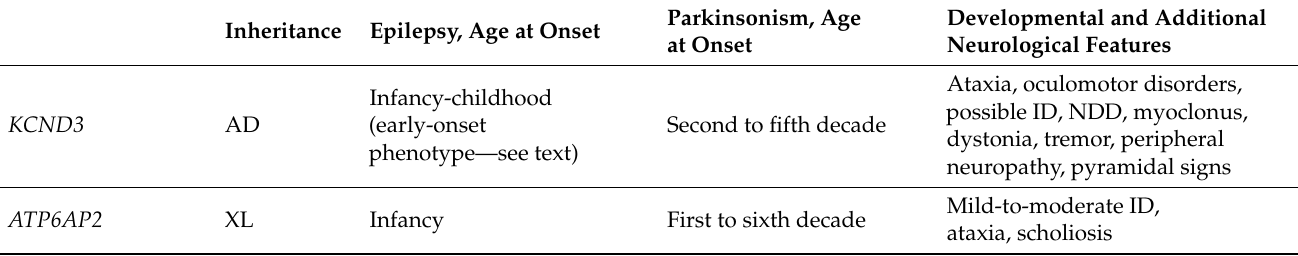
Table 4. Juvenile Parkinsonism genes with possible association of